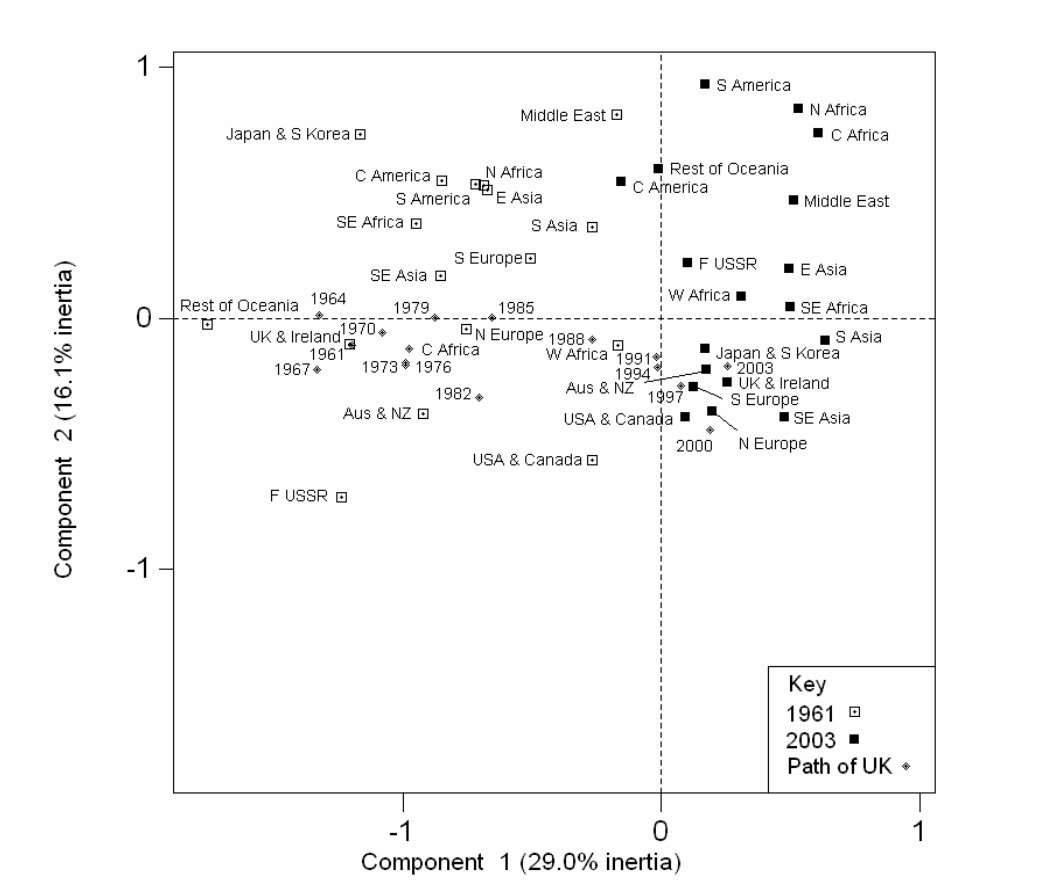
Figure 3b: Correspondence analysis – world regions plotted by the importation of different edible lipids in 1961 and